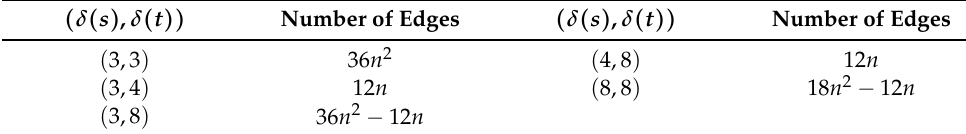
Table 1. Degree-based edge partition for